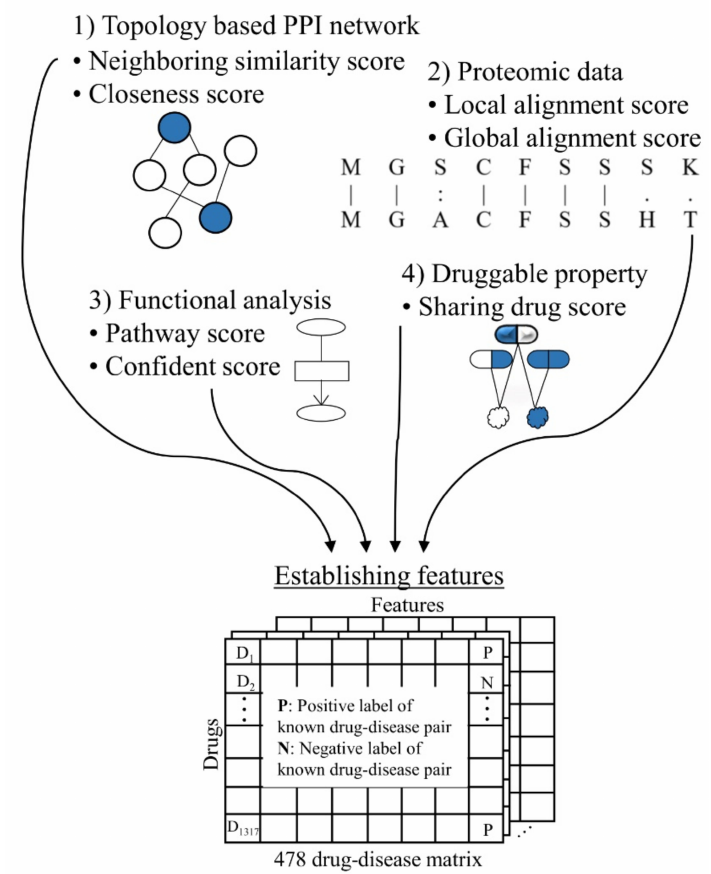
Figure 2. Overview of protein–protein similarity vectors (PPSVs)